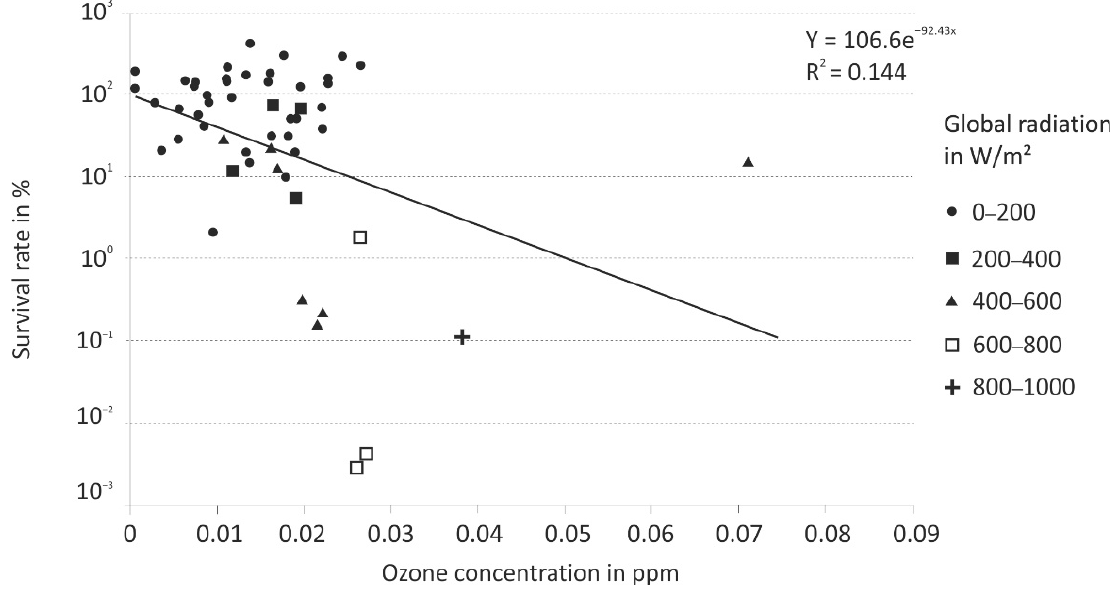
Figure 8. Survival rates of Staphylococcus xylosus after 12 min in the airborne state as a function of ozone and the influence of global radiation ( n = 54).